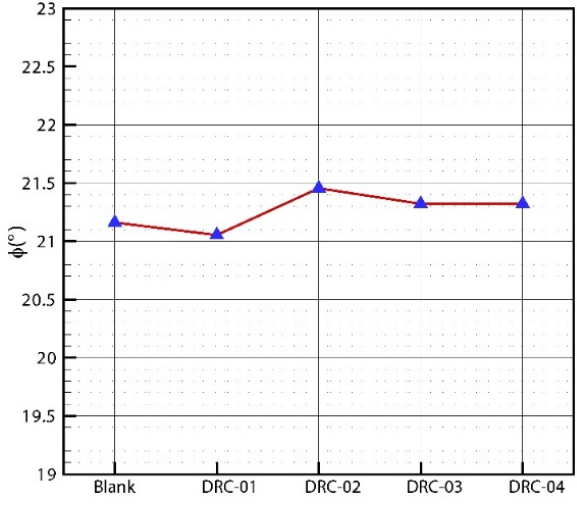
Figure 10. The comparison of flow turning